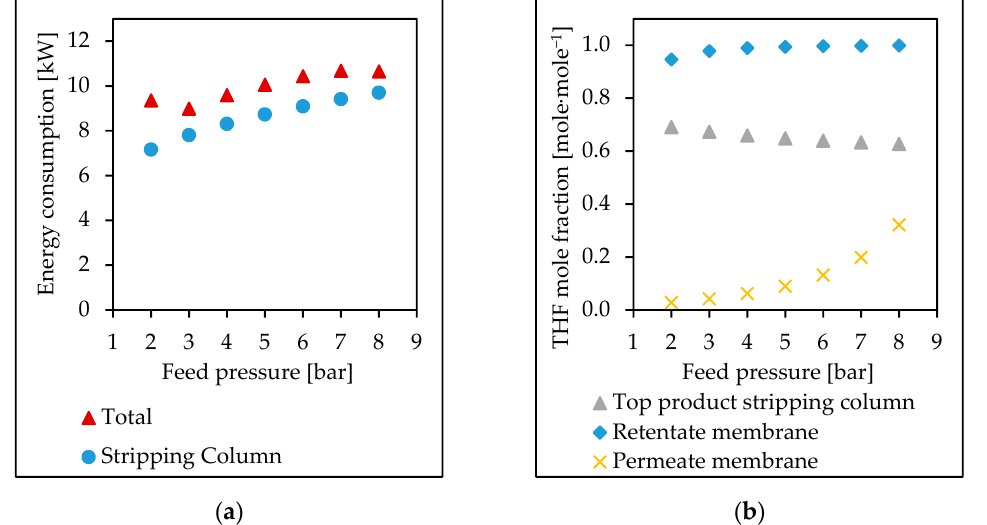
Figure 7. ( a ) Energy consumption of the whole process (Total) and the energy consumption of the stripping process part (Stripping column) and ( b ) THF mole fraction of the product streams in dependence of the used feed pressure for stripping column (top product) and membrane process (permeate and retentate stream).